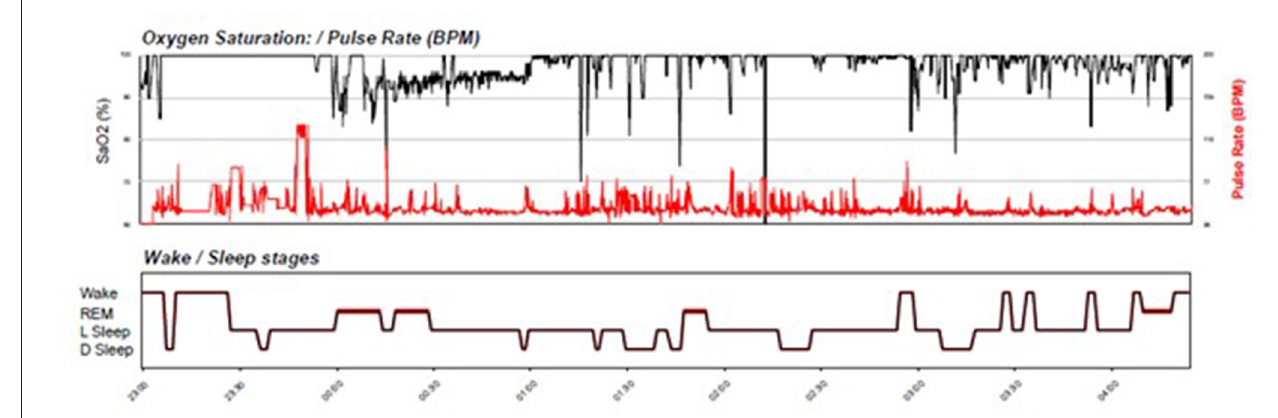
FIGURE 1 | Raw sleep indices measured in sleep on a given night.